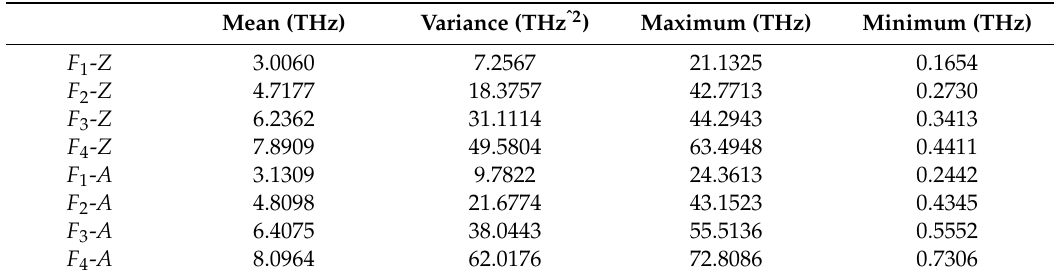
Table 2. Probability results of LHS in a finite element model of graphene*.